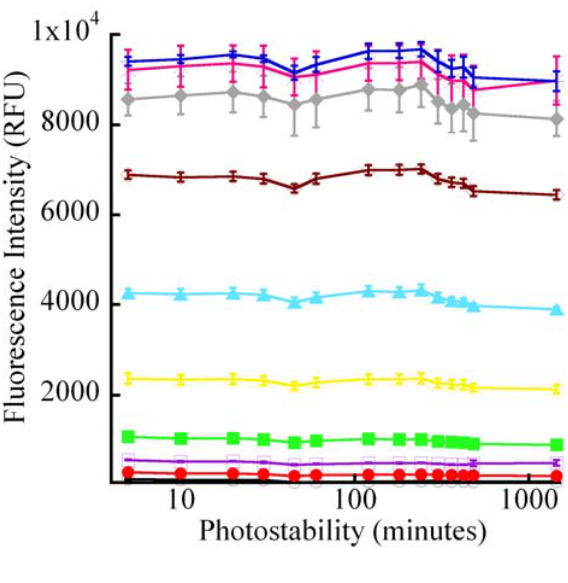
red), 5 (open squares, purple), 10 (closed squares, green), 25 (open triangles, yellow), 50 (closed triangles, aqua), 100 (open diamonds, maroon), 250 (closed diamonds, grey), 500 (crosses, magenta) and 1000 (plusses,